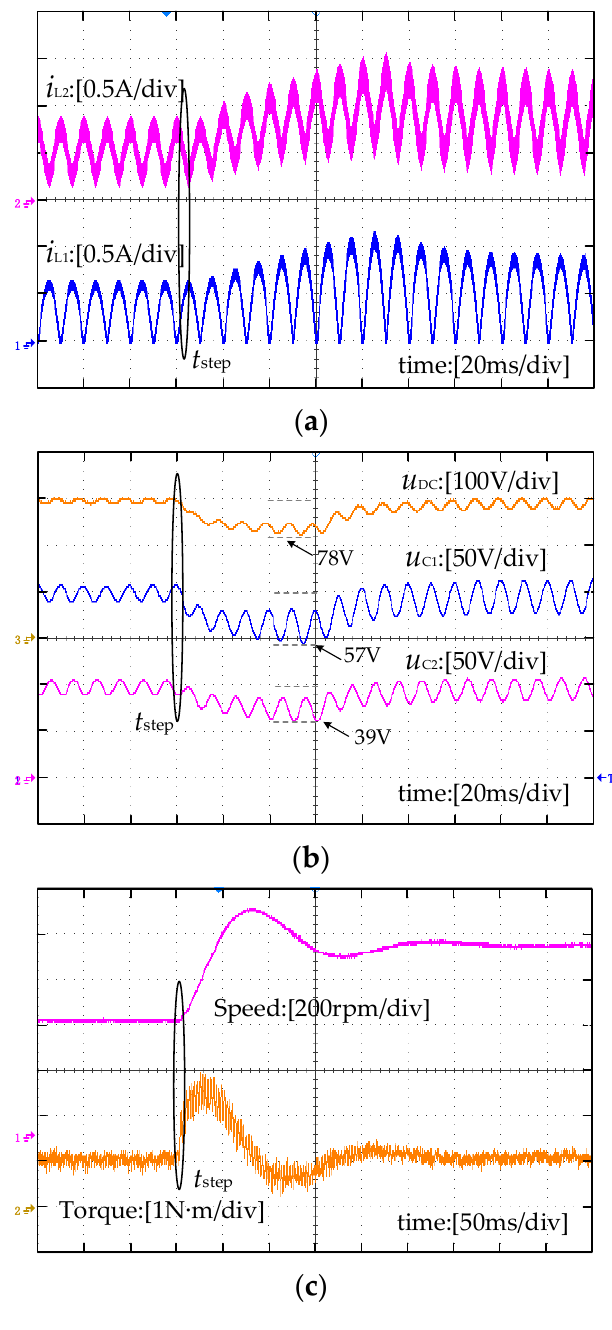
Figure 8. Dynamic experimental waveforms of ECL motor driver under traditional PI control with speed-up from 500 to 800 rpm. ( a ) The current of L 1 and the current of L 2 . ( b ) DC-link voltage u DC , the voltage of C 1, and the voltage of C 2 . ( c ) Motor speed and motor torque. µ F DC-link capacitor, which has the same experimental conditions as Figure 6. In this experiment, the maximum drop of DC-link voltage is 30 V. The conventional motor drive system takes 120 ms to restore the drop voltage of the DC-link to the set value and takes 210 ms to reach the given 800